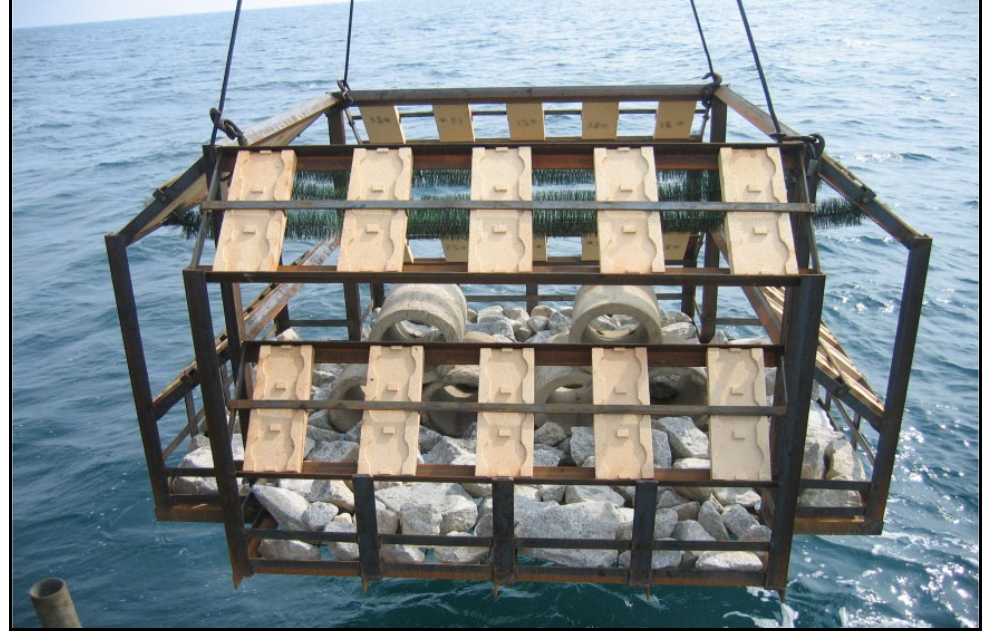
Figure 2. Photograph of the BK module prior to being deployed at Tukun Telaga Batin off the coast of Terengganu in 2003.